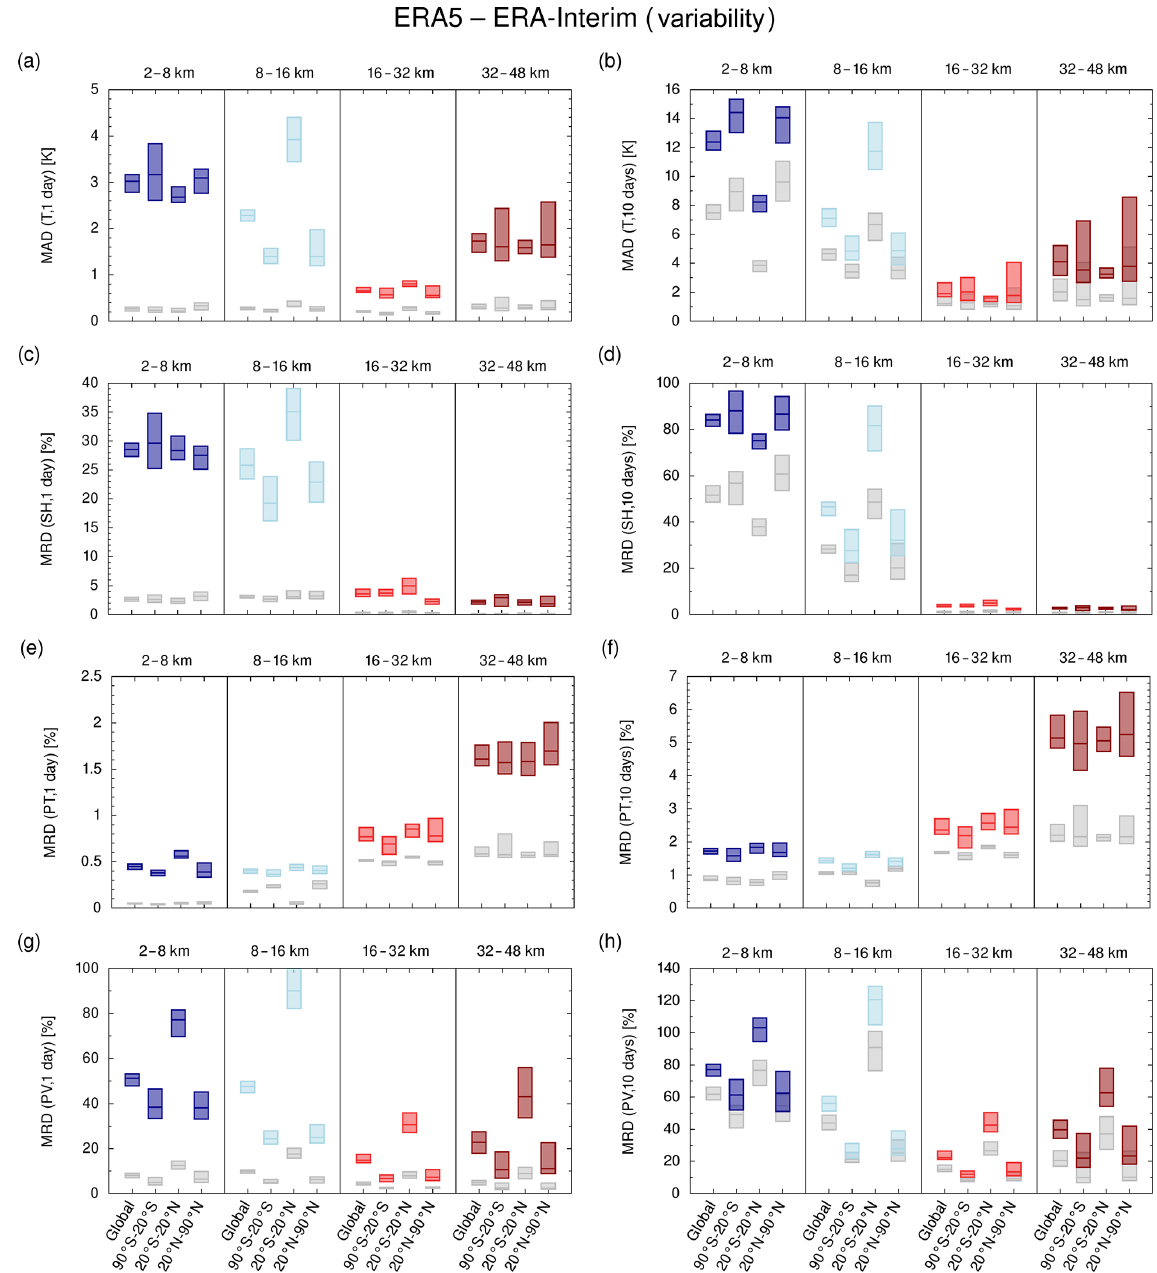
Figure 10. Temperature ( T ), specific humidity (SH), potential temperature (PT), and potential vorticity (PV) deviations between ERA- Interim and ERA5 (blue and red bars) and due to parameterized diffusion and subgrid-scale wind fluctuations (light gray bars) after 1 day (a, c, e, g) and 10 days (b, d, f, h) of simulation time. Bars indicate the peak-to-peak range and the median of 24 trajectory simulations covering the year